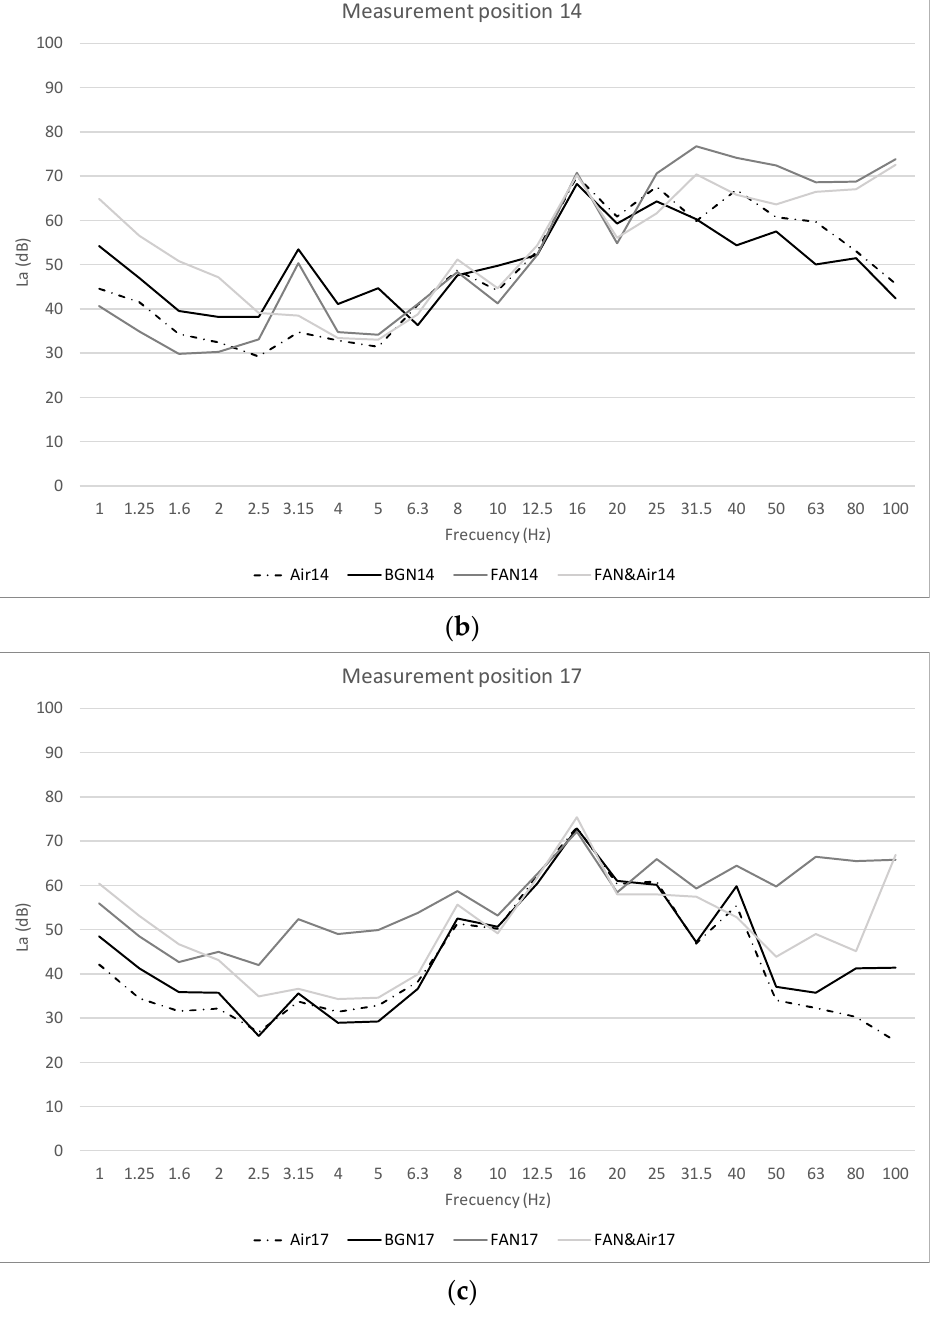
Figure 5. Acceleration levels La (dB), at measurement positions 11, 14 and 17, for the four scenarios studied and in the frequency range 0–100 Hz: ( a ) Position 11; ( b ) Position 14; ( c ) Position 17. Figure 6 shows the average values of the acceleration level La (dB), comparing the same FAN_Motor&Air scenario, points 11, 14, and 17: points on the motor (11), on the tray covering the motor (14), and on the mattress on top of the tray (17).